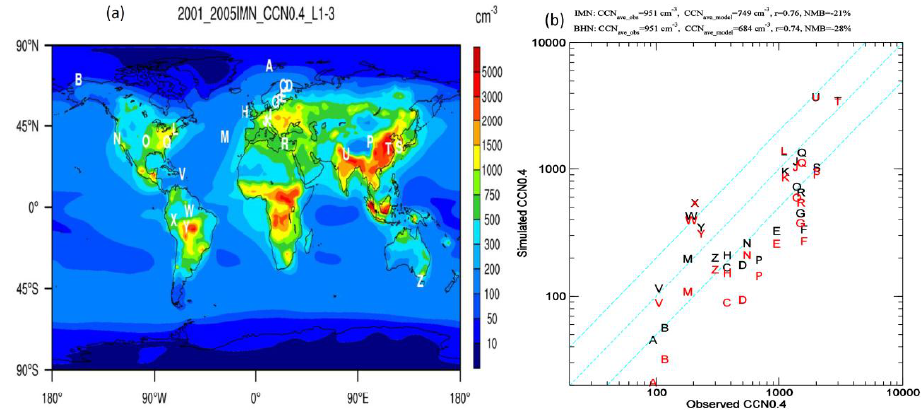
Fig. 3. (a) Horizontal distribution of the 5-yr mean number concentrations of CCN (defined at a water supersaturation of 0.4% – CCN0.4) Figure 3. averaged within the lower boundary layer (0 − ∼ 0.4km) ([CCN0.4] LBL ) , as predicted by CAM5-MAM3 with IMN scheme. (b) Comparison of simulated [CCN0.4] LBL based on both IMN (black letters) and BHN (red letters) schemes with observed values at 26 sites around the globe (locations are indicated in Fig. 3a by the letters). In (b) , model results correspond to the months of the observations. The CCN0.4 data include those compiled by Andreae (2009) and additional data points from recent publications as well as archival observations as described in Yu et al.